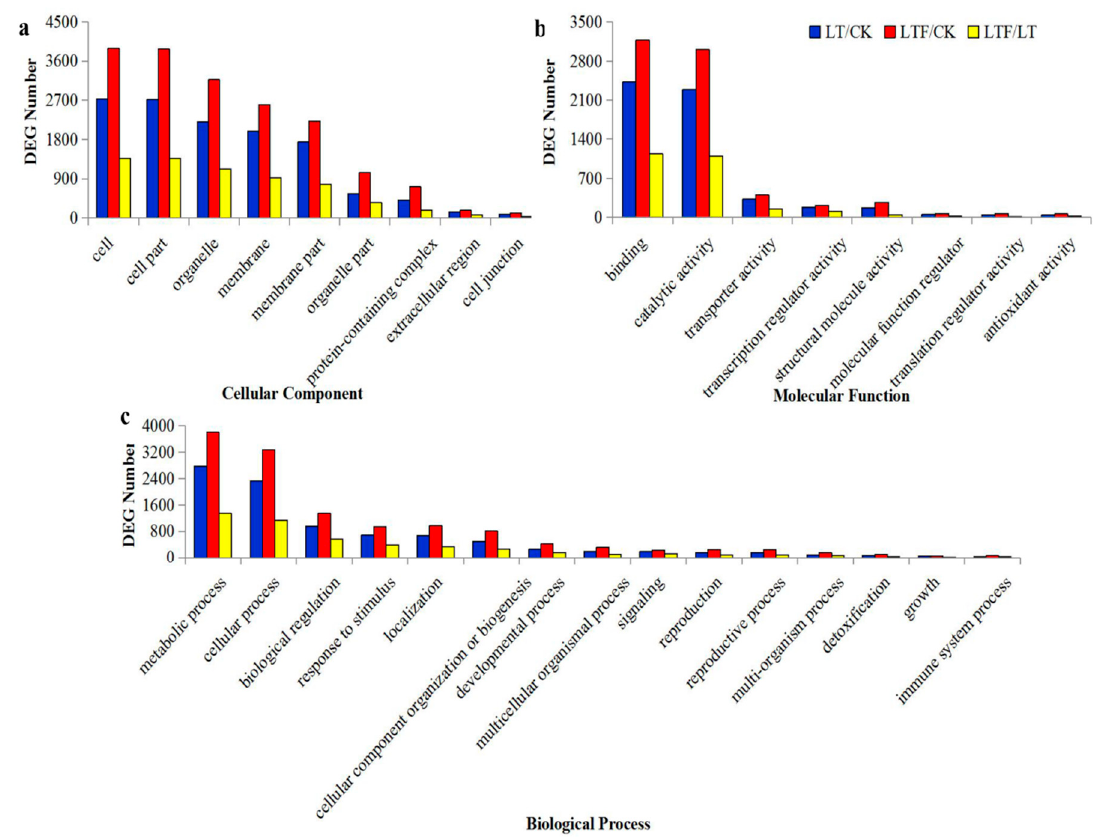
Figure 4. GO enrichment analysis of DEGs in leaves of rice seedlings. LT, low temperature treatment for 3d; LTF, low temperature flooding treatment for 3d; CK, control.